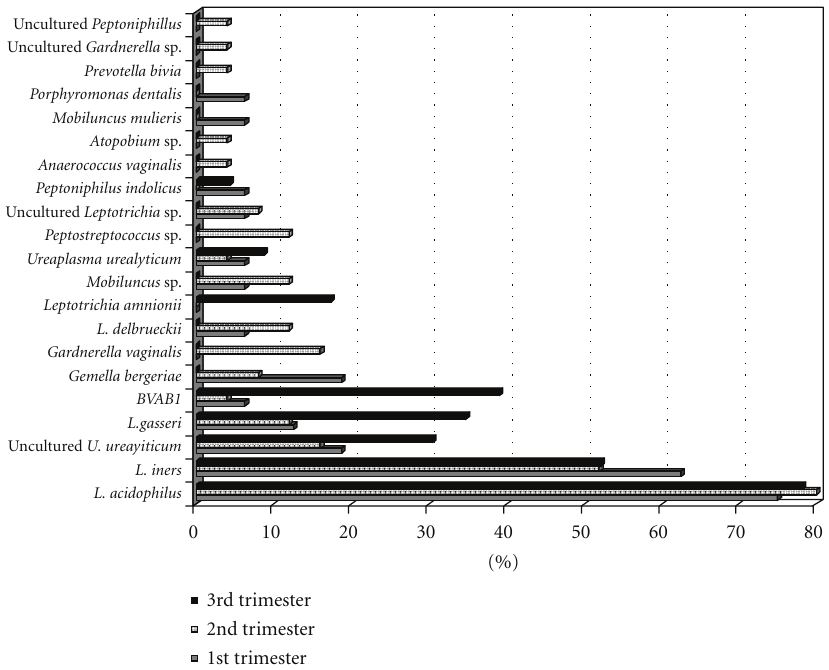
Figure 5: Distribution of 21 di ff erent microorganisms identified in vaginal tract of women studied ( n = 64) by trimester of pregnancy. sixteen bacteria from the total number of species